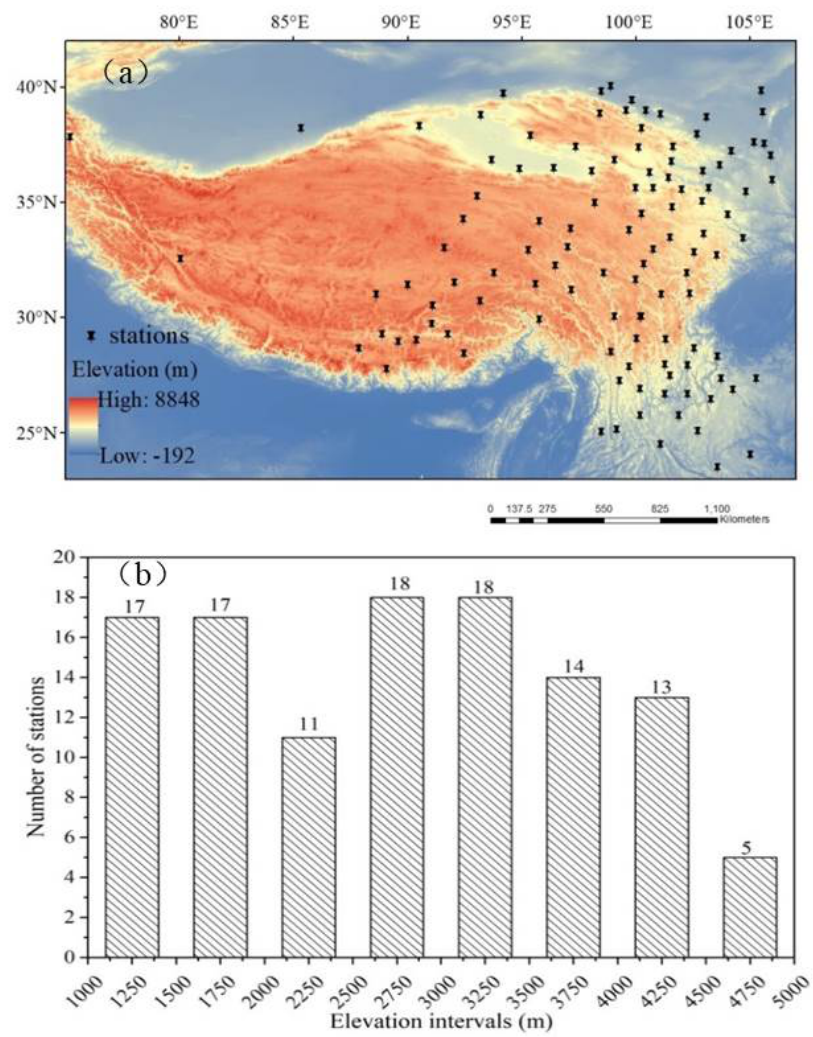
Figure 1. Topographic map of the TP and TPS with 113 weather stations from CMA (a),And the elevation distribution of stations with number of stations for each elevation interval is shown(b).